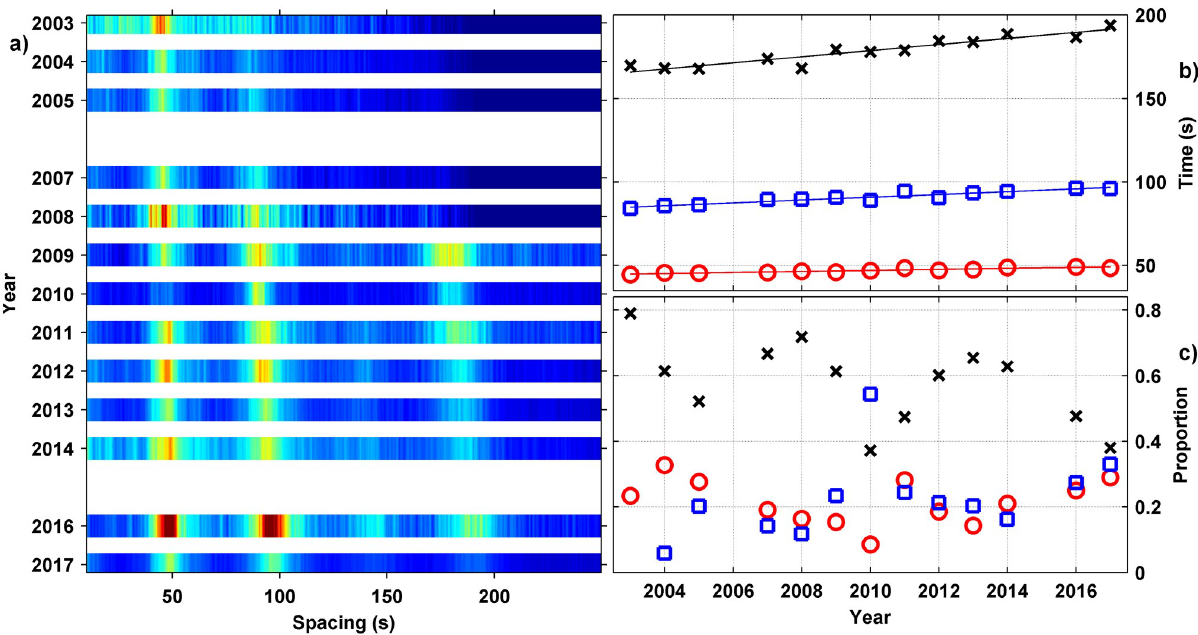
Fig 10. ISI-analysis for all seasons. (a) Density distribution of type II repeat interval for all years (normalised with the colour scale from 0 = blue to 1 = red), (b) peak time interval across years over 30–60 s (red circle, P1 song ISI), 70–100 s (blue square, P2 song ISI) and 160–200 s (black cross ( P3 song ISI), and c) proportion of song-repeat values with year (same symbols and colours as b). The solid lines on b) are linear fits. The resolution used in a) was 0.1 s and 0.25 dB.